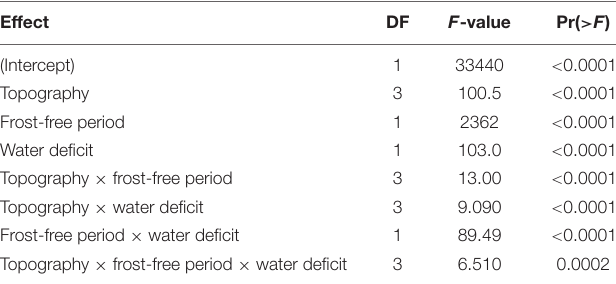
TABLE 4 | ANOVA of effects of topography and macroclimate on proportion of divaricate species in arborescent assemblages across 9,601 plots, by Satterthwaite’s